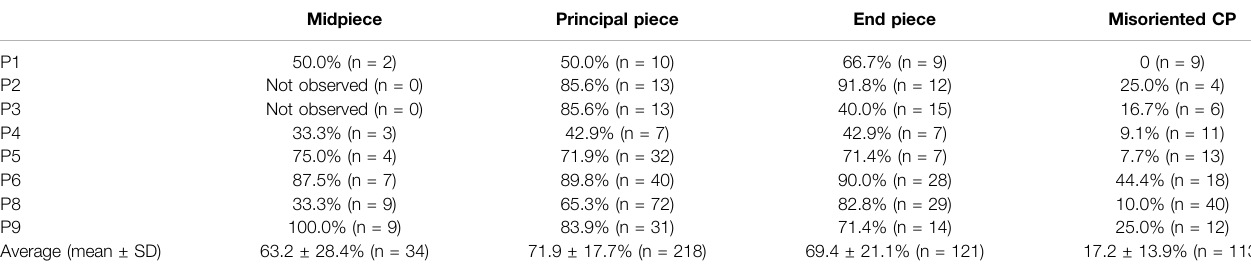
TABLE 2 | Percentage of abnormal cross-sections in patients.